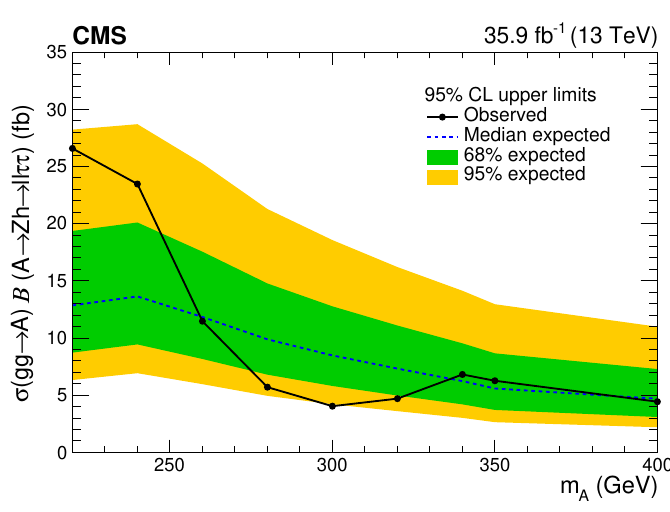
Figure 5 . The expected and observed 95% CL model-independent upper limits on the product of the cross section and branching fraction (cid:27) (gg ! A) B (A ! Zh ! ‘‘ tt ) are shown. The green (yellow) band corresponds to the 68 (95)% con(cid:12)dence intervals for the expected limit.